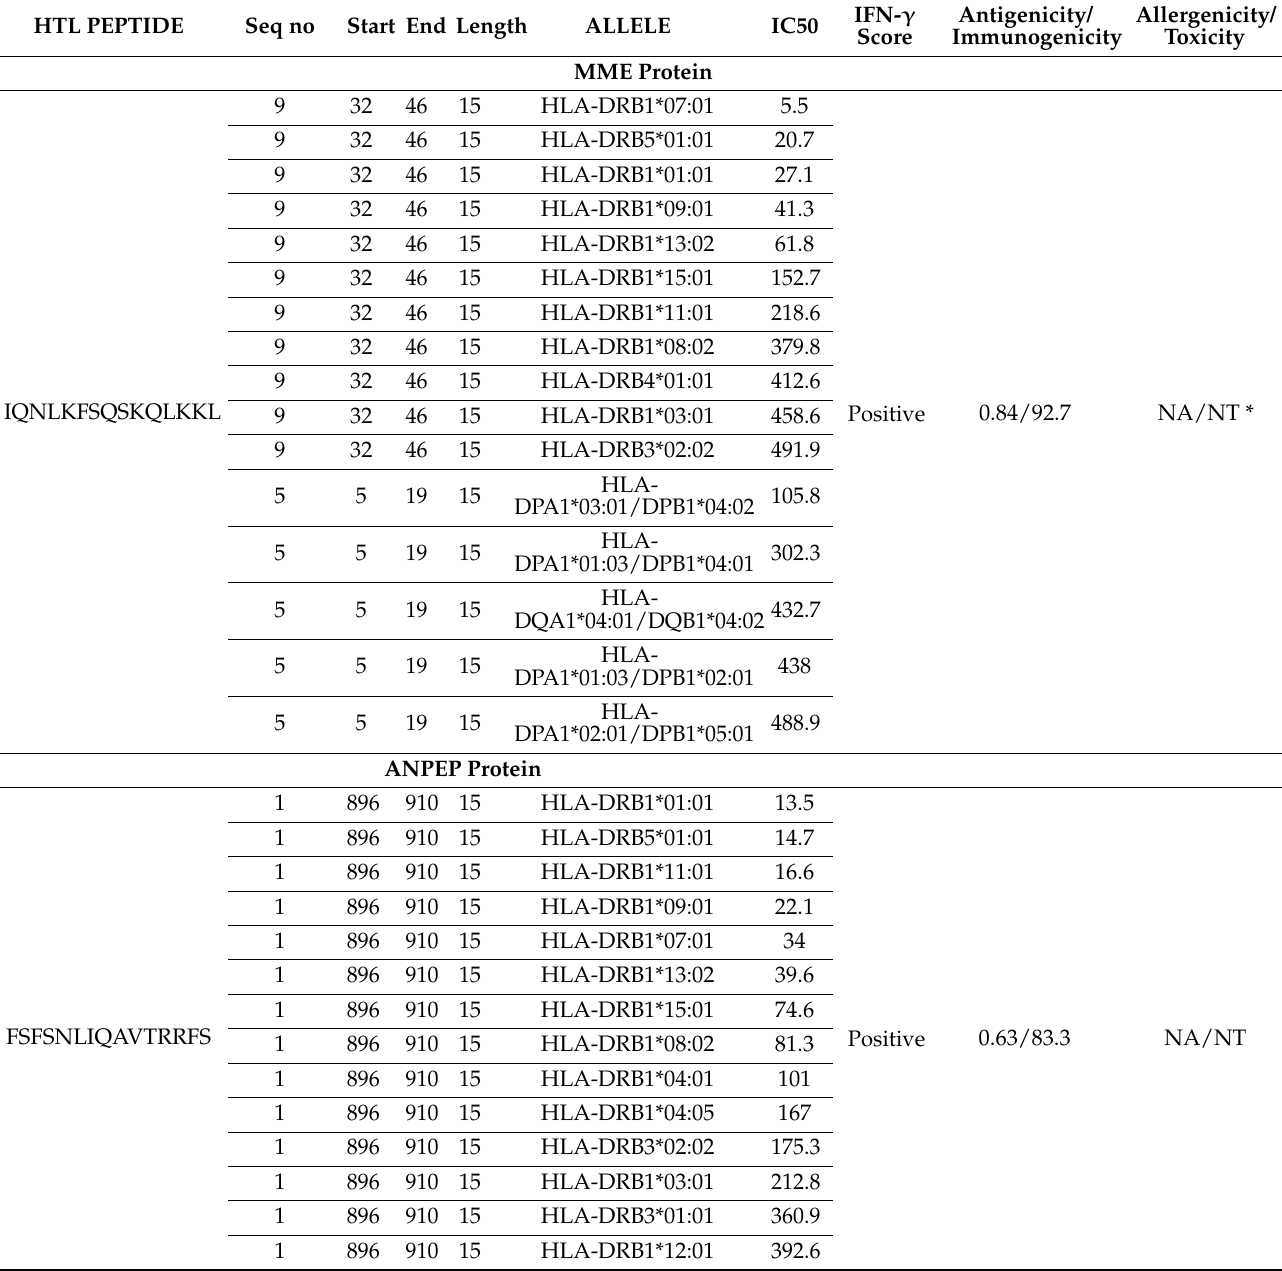
Table 2. List of HTL epitopes selected for design of vaccine construct. HTL